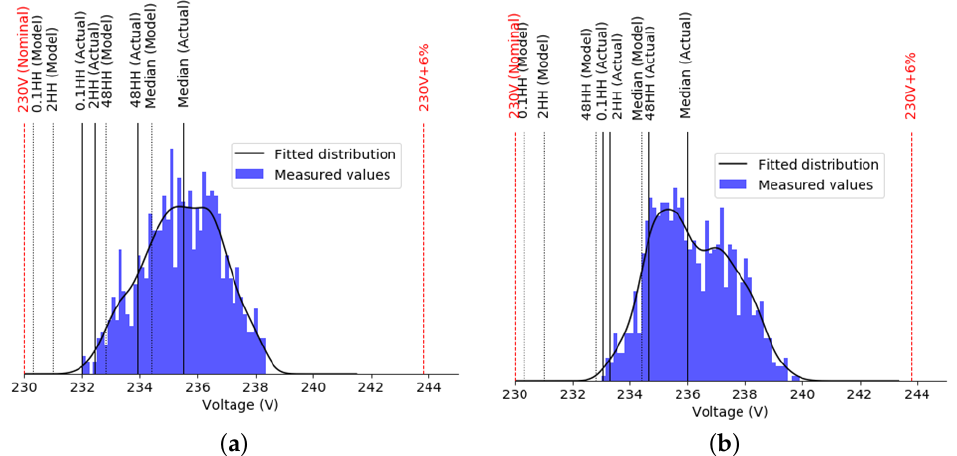
Figure 9. Comparison of modelled versus actual voltage distributions at the circuit 2 bus over two winter weeks ( a ) July, ( b ) August. Key percentiles are marked on the graph with dotted lines for simulated results and solid lines for measured